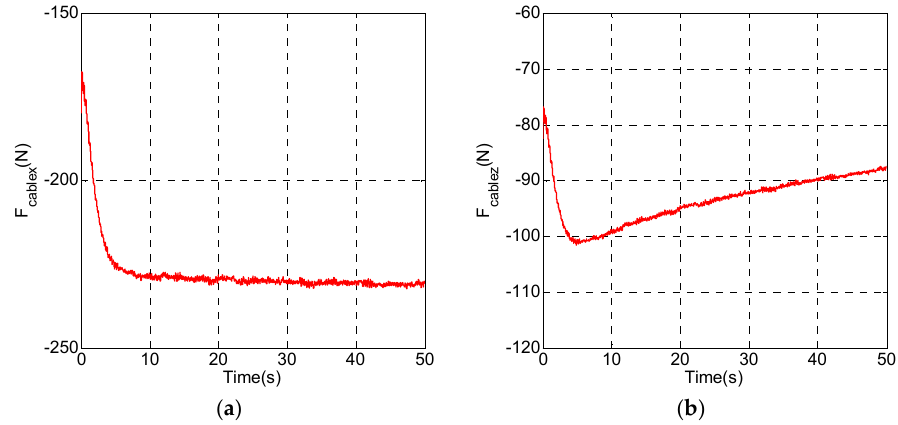
Figure 14. Cable disturbing force (LPM): ( a ) cable force in the X direction; ( b ) cable force in the Z direction. Appl. Sci. 2018 , 1, x FOR PEER REVIEW